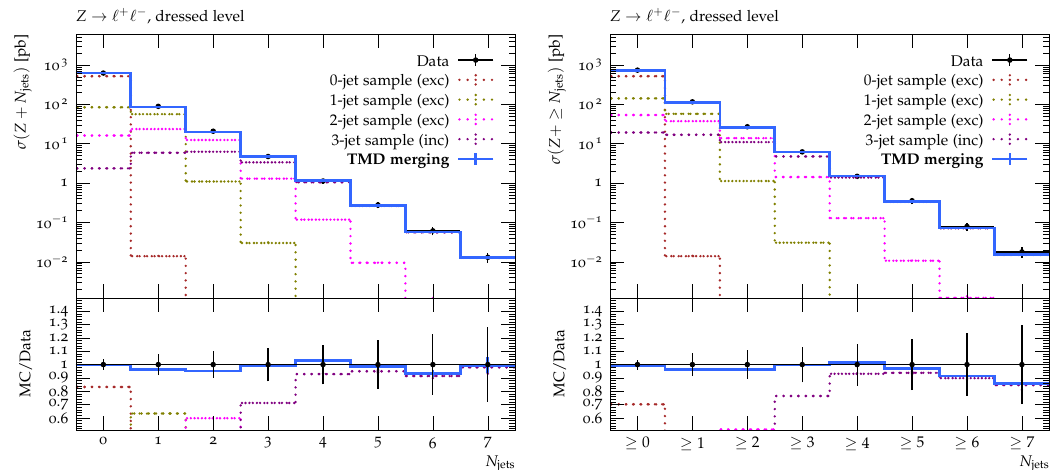
Figure 10 . Exclusive (left) and inclusive (right) jet multiplicity distributions in the production of a Z -boson in association with jets. Experimental measurements by ATLAS [91] at are compared to predictions using the TMD merging calculation. Separate contributions from the different jet samples are shown. All the jet multiplicities are obtained in exclusive (exc) mode except for the highest multiplicity which is calculated in inclusive (inc) mode.